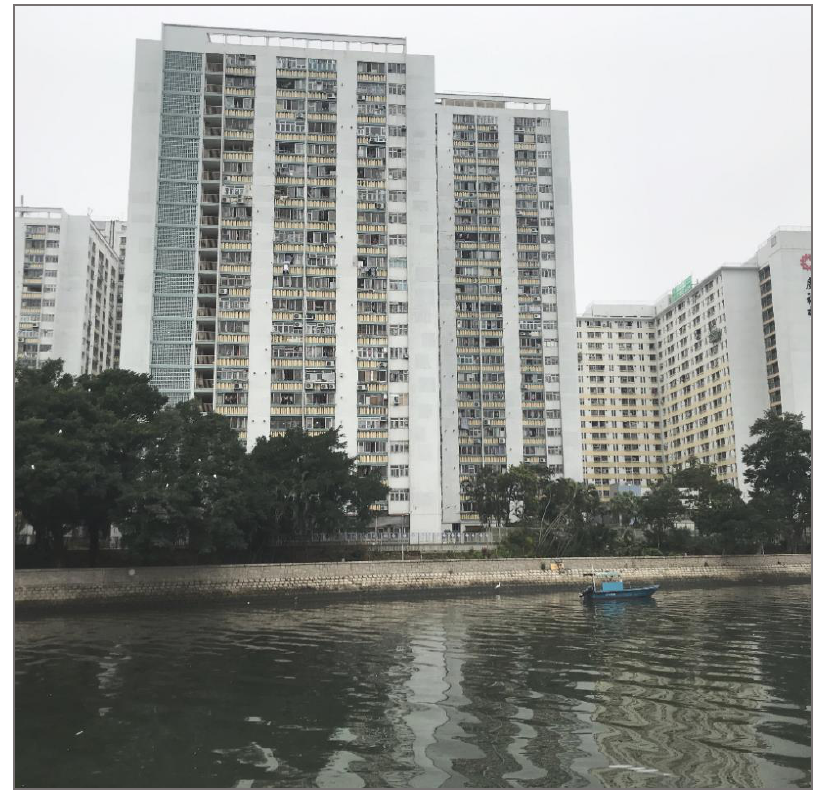
Figure 2. Apartment Building in Tai Po. (Source: authors).